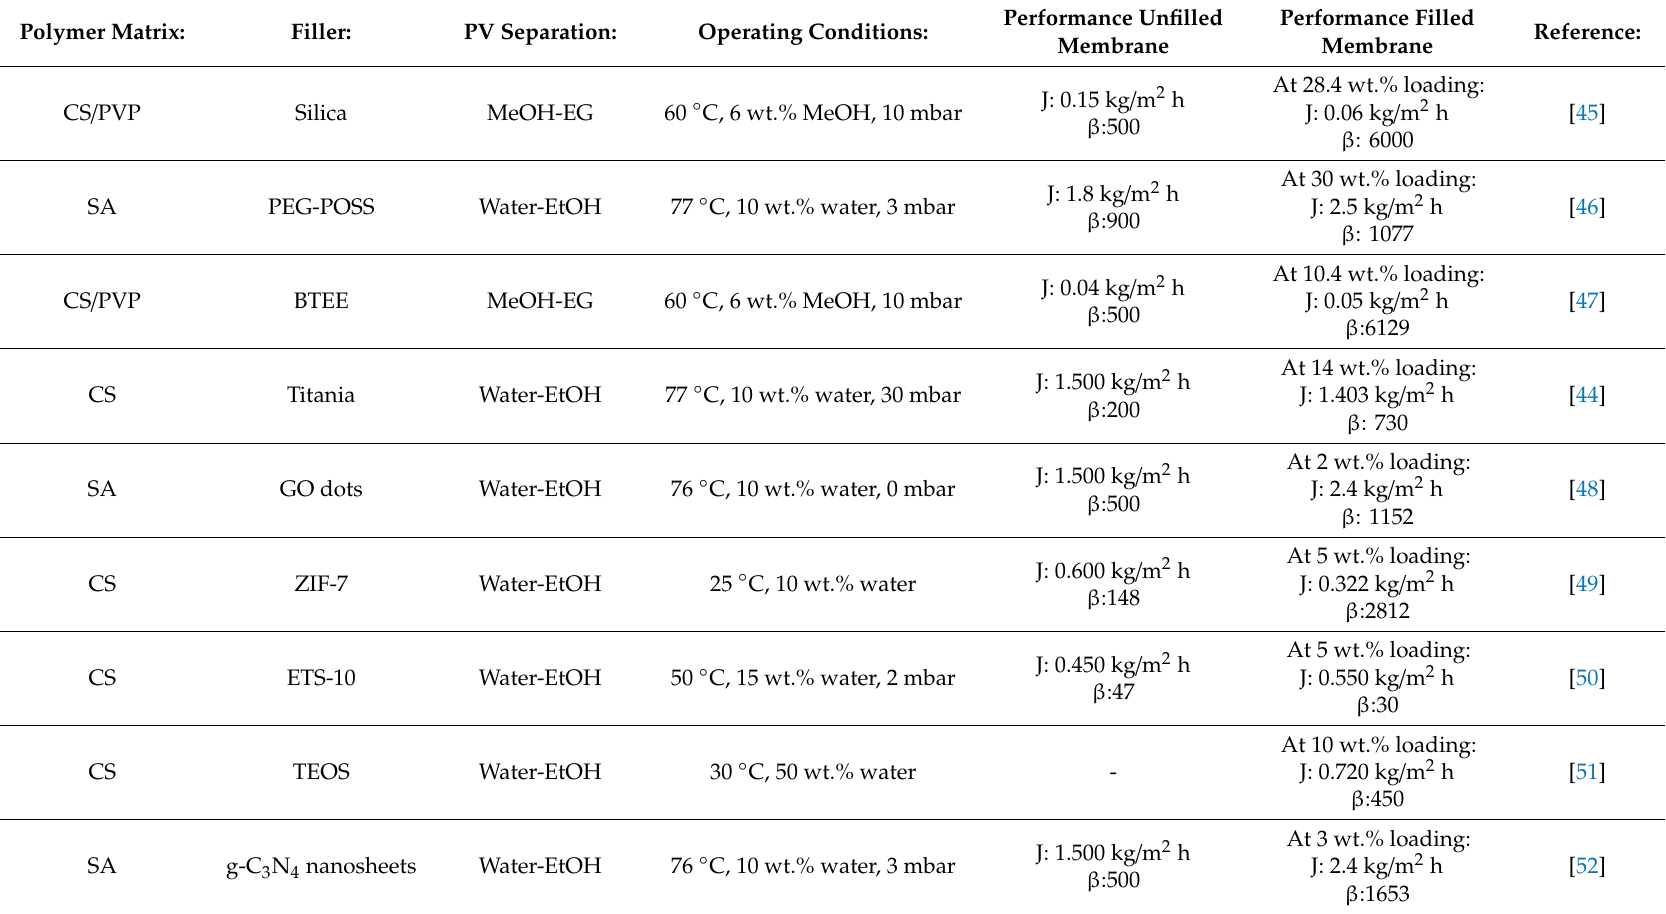
Table 2. Ongoing development works using biopolymer-based membranes for